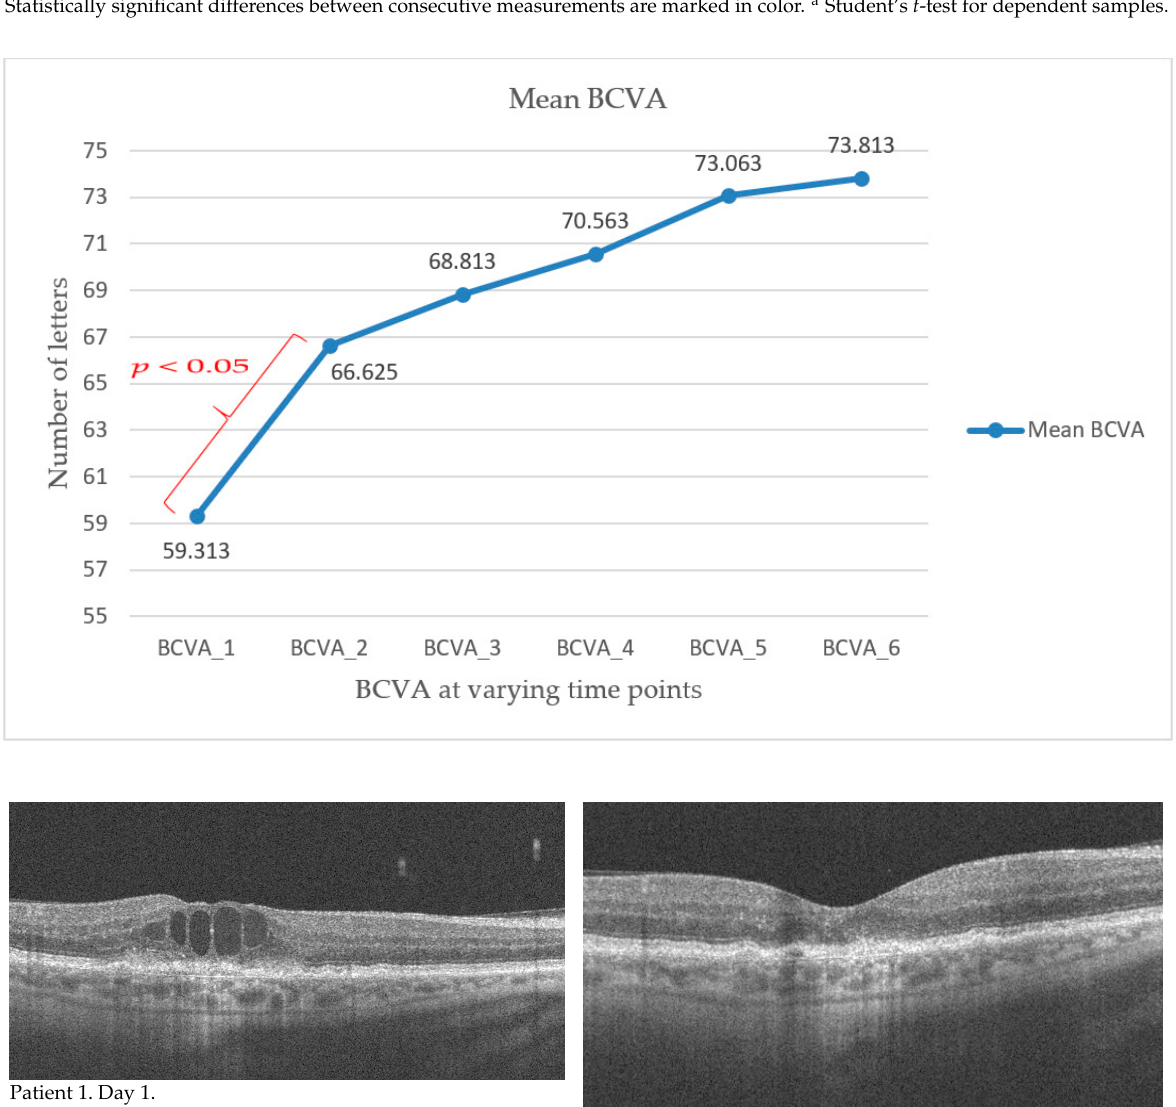
Table 2. BCVA – Descriptive statistics and statistical significance of